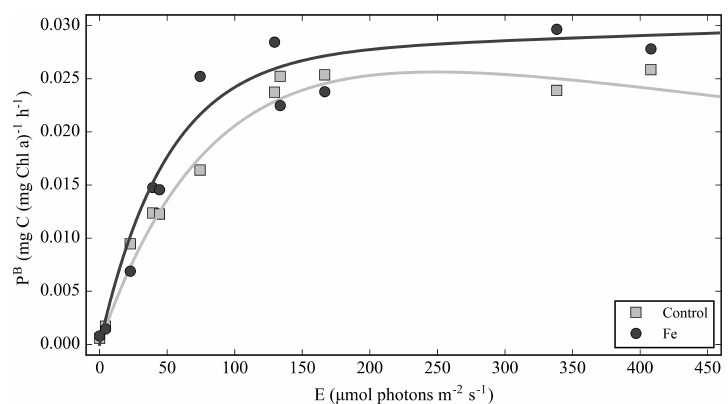
Figure 2. An example of a PE curve of productivity (mgC(mgChl a ) − 1 h − 1 ) versus irradiance (µmolphotonsm − 2 s − 1 ) , with (Fe) and without (Control) the addition of iron; the lines represent a non-linear least squares fit to the equation of Platt et al. (1980). Table 2. Summary of PE parameters, α B (mg(mgChl a ) − 1 h − 1 (µmolphotonsm − 2 s − 1 ) − 1 ) , P B max (mg(mgChl a ) − 1 h − 1 ) and E k (µmolphotonsm − 2 s − 1 ) , for the ρ C nutrient addition